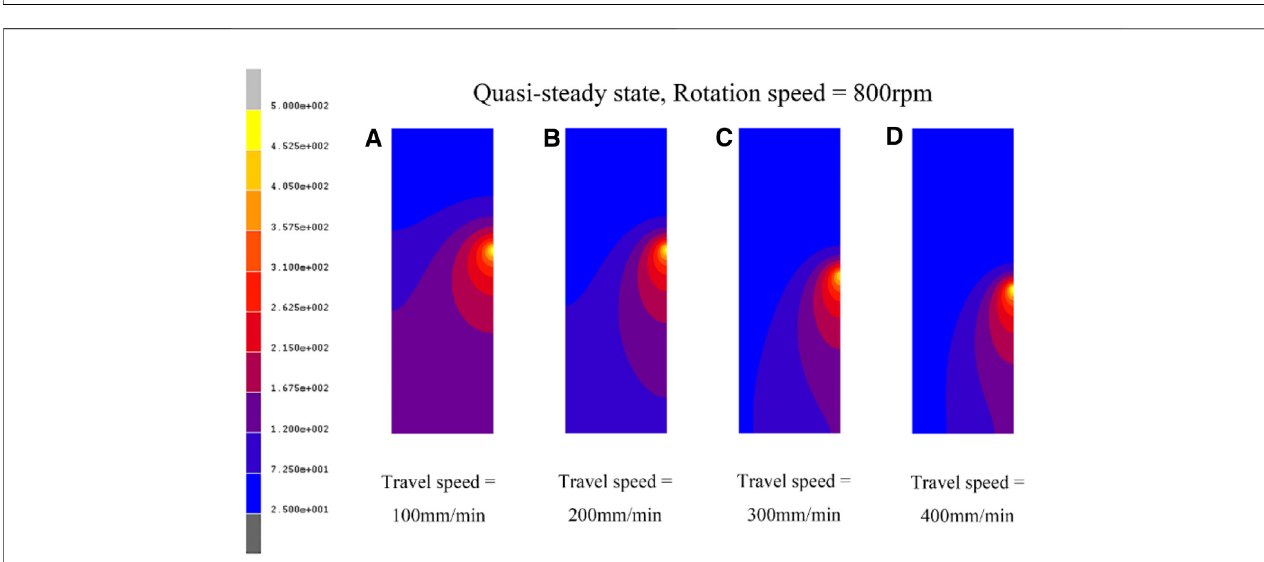
FIGURE 15 | Contours of temperature distribution on the upper surface under different travel speeds. (A) 100 mm/min, (B) 200 mm/min, (C) 300 mm/min, (D) 400 mm/min.